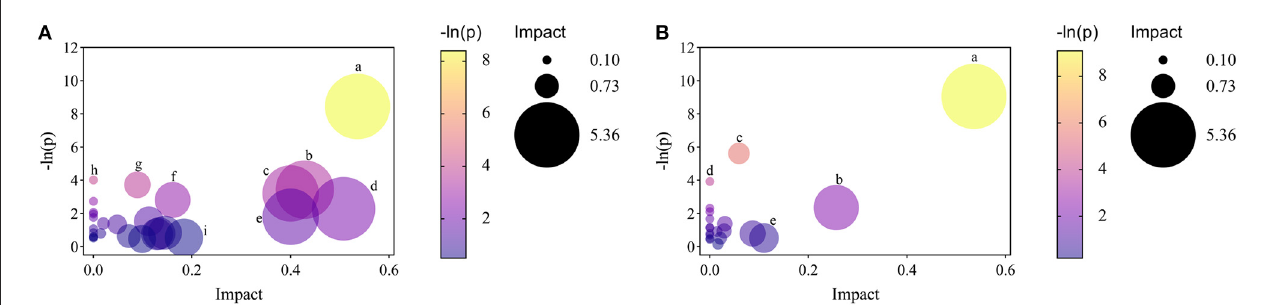
FIGURE7 The analyses of related pathways changes by KFP-M. (A) AM vs. CK groups. (a) nicotinate and nicotinamide metabolism. (b) taurine and hypotaurine metabolism. (c) pyrimidine metabolism. (d) glycine, serine and threonine metabolism. (e) thiamine metabolism. (f) arginine and proline metabolism. (g) primary bile acid biosynthesis. (h) biosynthesis of unsaturated fatty acids. (i) valine, leucine and isoleucine biosynthesis. (B) KFP-M vs. AM groups. (a) nicotinate and nicotinamide metabolism; (b) alanine, aspartate and glutamate metabolism. (c) histidine metabolism; (d) D-arginine and D-ornithine metabolism; (e) D-glutamine and D-glutamate metabolism.